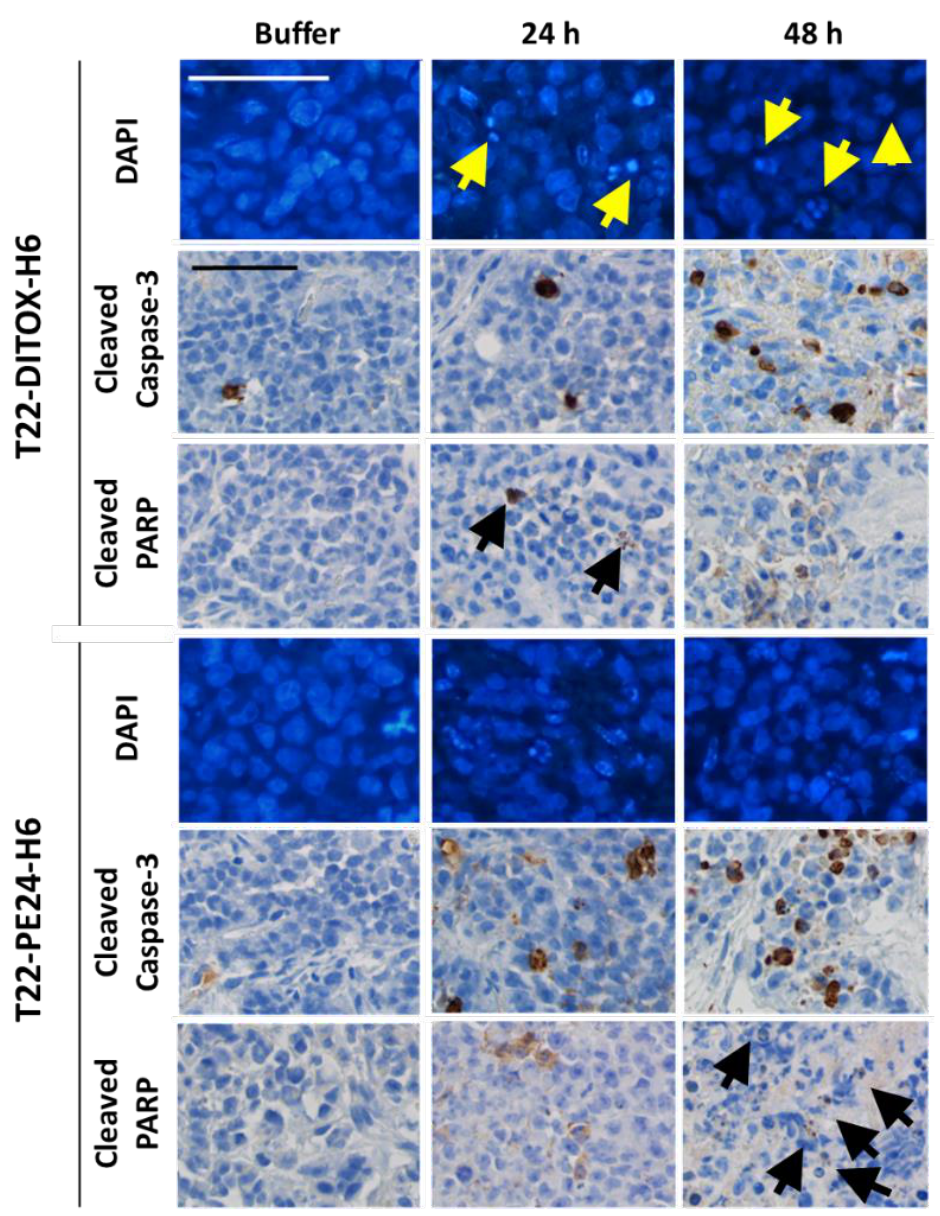
Figure 4. T22-DITOX-H6 and T22-PE24-H6 nanotoxin treatment activates apoptosis in vivo in a subcutaneous tumor generated in the CXCR4 + AN3CA EC model. Mice were treated with a single bolus of either buffer, 100 µ g T22-DITOX-H6 or 30 µ g T22-PE24-H6. Tumor sections were stained with fluorescent DAPI, showing DNA condensation in apoptotic bodies, and IHC staining for markers of cleaved caspase- 3 and proteolyzed PARP. Arrows indicate positive cells. Bar: 50 μm.